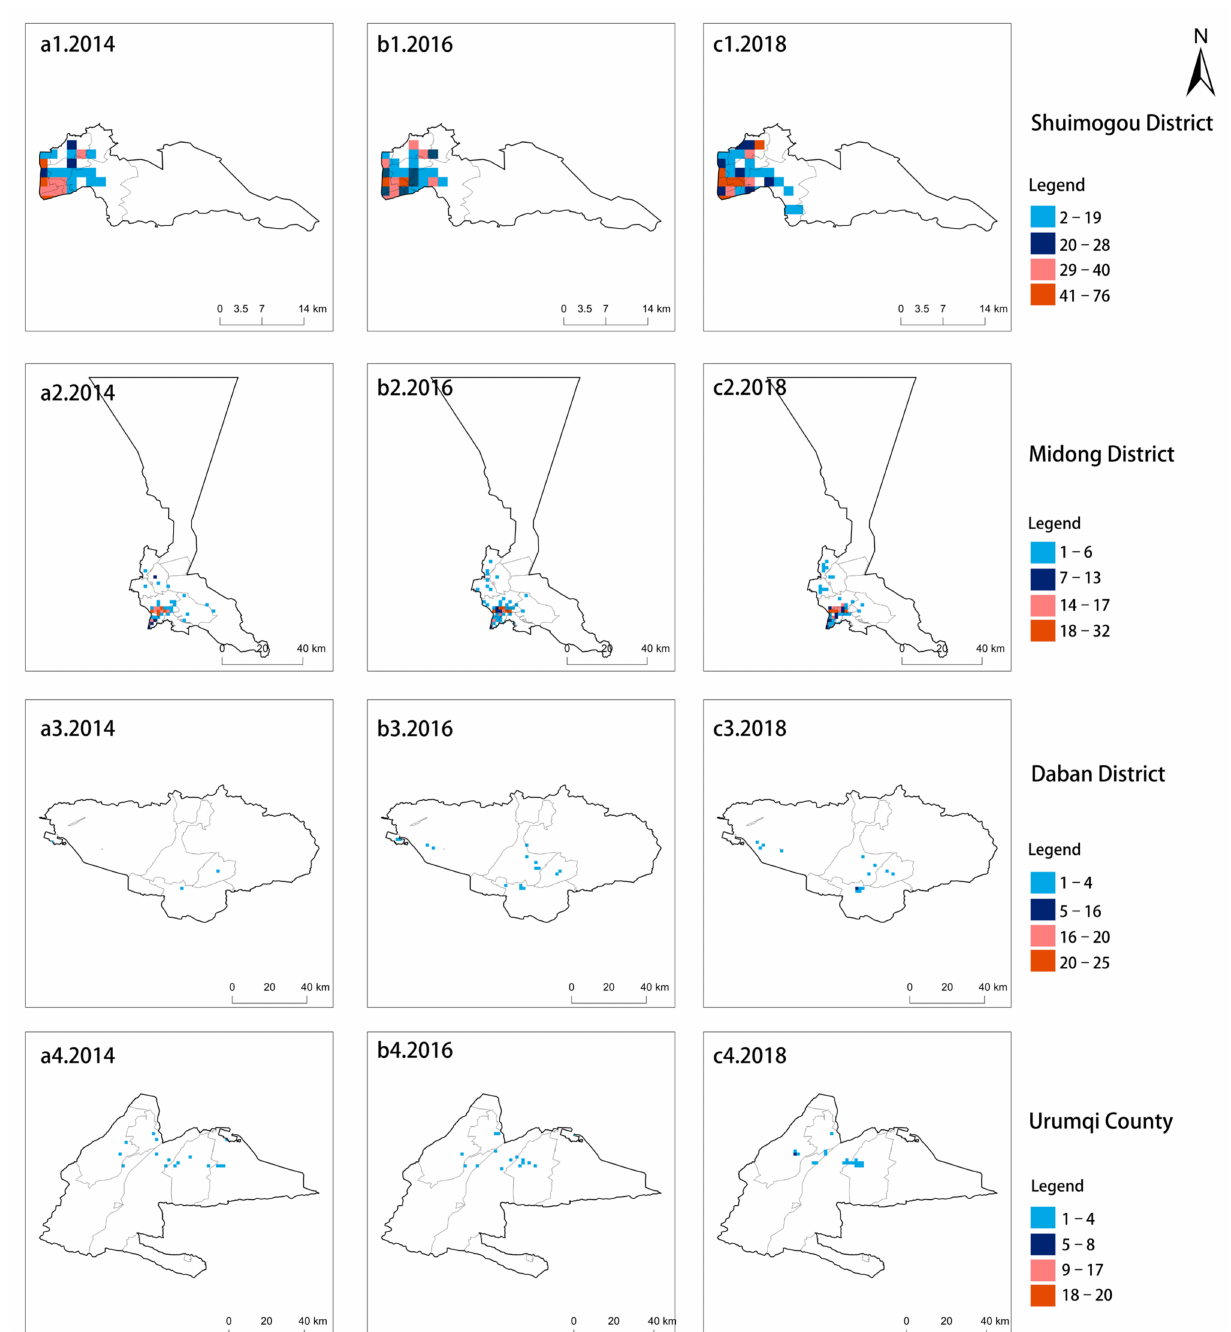
Figure 4. Low-density HFMD districts in Urumqi from 2014 to 2018 (( a1–a4 ). 2014, ( b1 – b4 ). 2016, ( c1 – c4 ). 2018). The temporal distribution characteristics of HFMD in Urumqi are shown in Table 3 and Figure 4. The annual-scale analysis showed that (Table 3) 2014 had the lowest number of cases, with a total of 2553. In 2016, the number of HFMD cases was 3689, showing an increase of 1136 and the growth rate was 44.49%. The highest number of HFMD cases occurred in 2018, with 4483 cases and a growth rate of 21.52%. The month-scale analysis showed that (Figure 5) from December to March, new cases were rare, and the increase rate of morbidity was extremely slow. From April to May, the number of new cases gradually increased. From June to July, the number of new cases increased sharply and